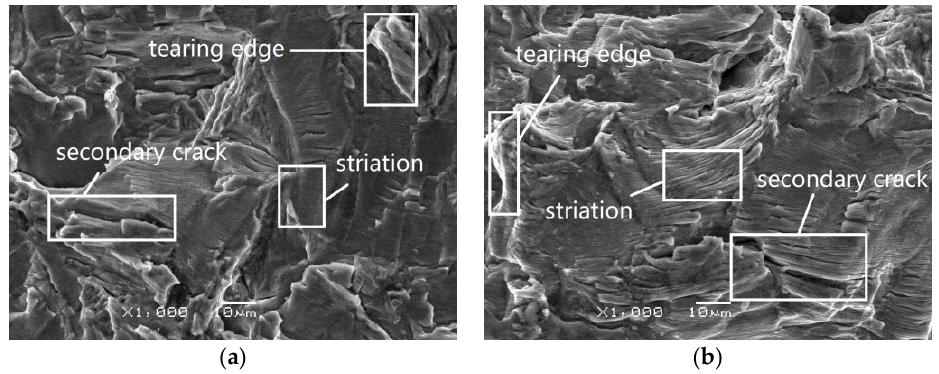
Figure 14. Typical SEM micrographs showing dwell fatigue fracture surface morphology at different temperatures under low load ratio: ( a ) initial stage, room temperature; ( b ) initial stage, T = 300 °C; ( c ) steady stage, room temperature; ( d ) steady stage, T = 300 °C.